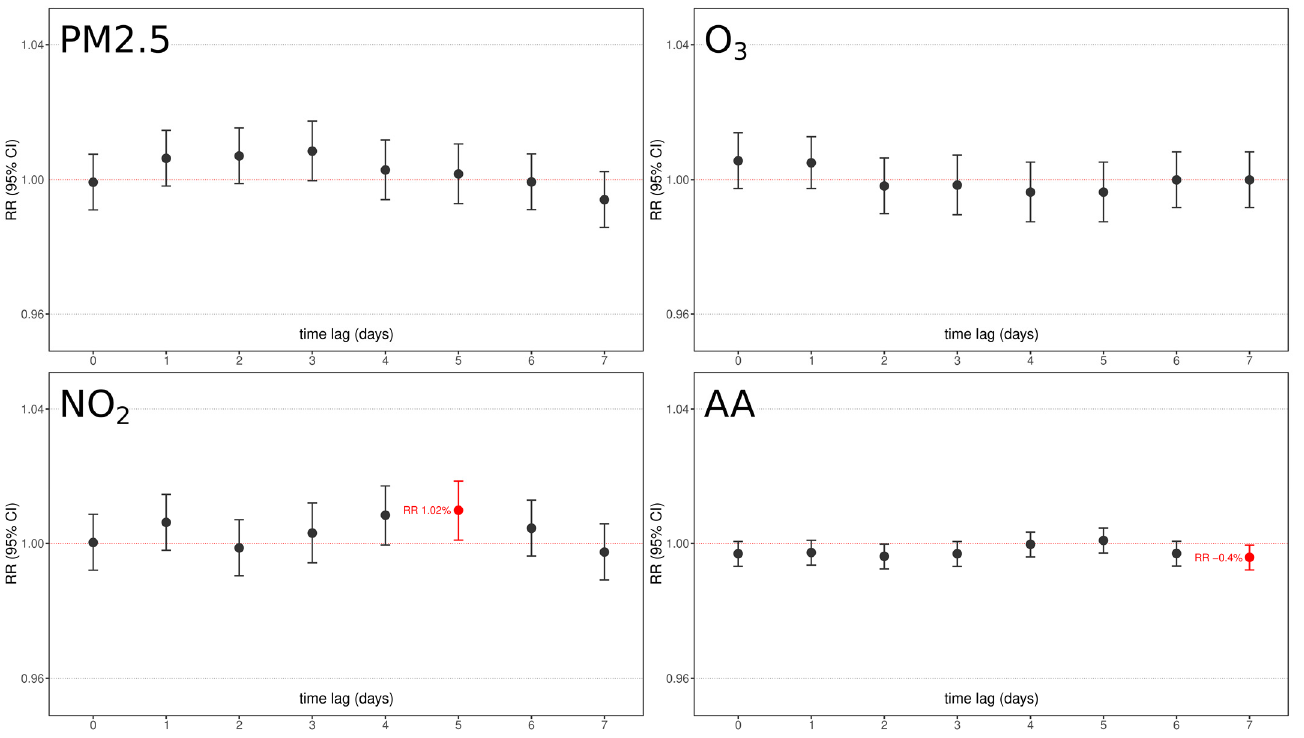
Figure 6. Graphical representation of chemical pollutants under analysis (PM2.5, NO 2 , O 3 ) and aeroallergen (AA) concentrations relative risk and confidence interval association with full-term births as per 7-days time lags. Red boxes underline significant factors with their relative lag RR. All models were adjusted for day of the week, holidays, summer population decrease, and yearly medium/long-term trend function.